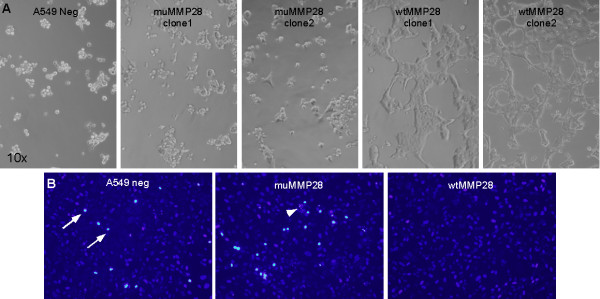
Over-expression of wild-type MMP28 confers a cell-survival advantage during serum-deprivation conditions. An equal number of A549 neg, wtMMP28 and muMMP28 cells (1-2 clones each, performed in duplicate) were plated onto collagen I-coated chamber slides in the absence of serum. (A) After 6 days in culture, the above images were obtained demonstrated floating cellular debris in the A549 neg and mutant clones (left 3 columns) and many viable cells in the wild-type clones (right 2 columns). Notably, initial adherence and spreading of the cells on collagen were similar, but survival after six-days of serum-deprivation was enhanced in clones expressing active MMP28. (B) Assessment of nuclear condensation and fragmentation (associated with apoptosis) using DAPI staining of serum-deprived cells at 24 h, revealed increased condensed (arrows) and fragmented (arrowhead) nuclei in only the A549 neg, muMMP28 cells and not wtMMP28.